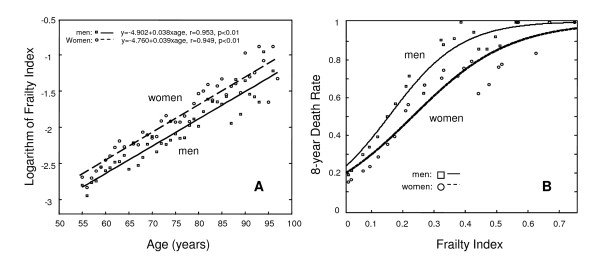
The relationship between age and the mean value of the FI (Panel A) and the eight-year death rate as a function of the FI (Panel B). Men: squares and solid line; women: circles and dashed line.